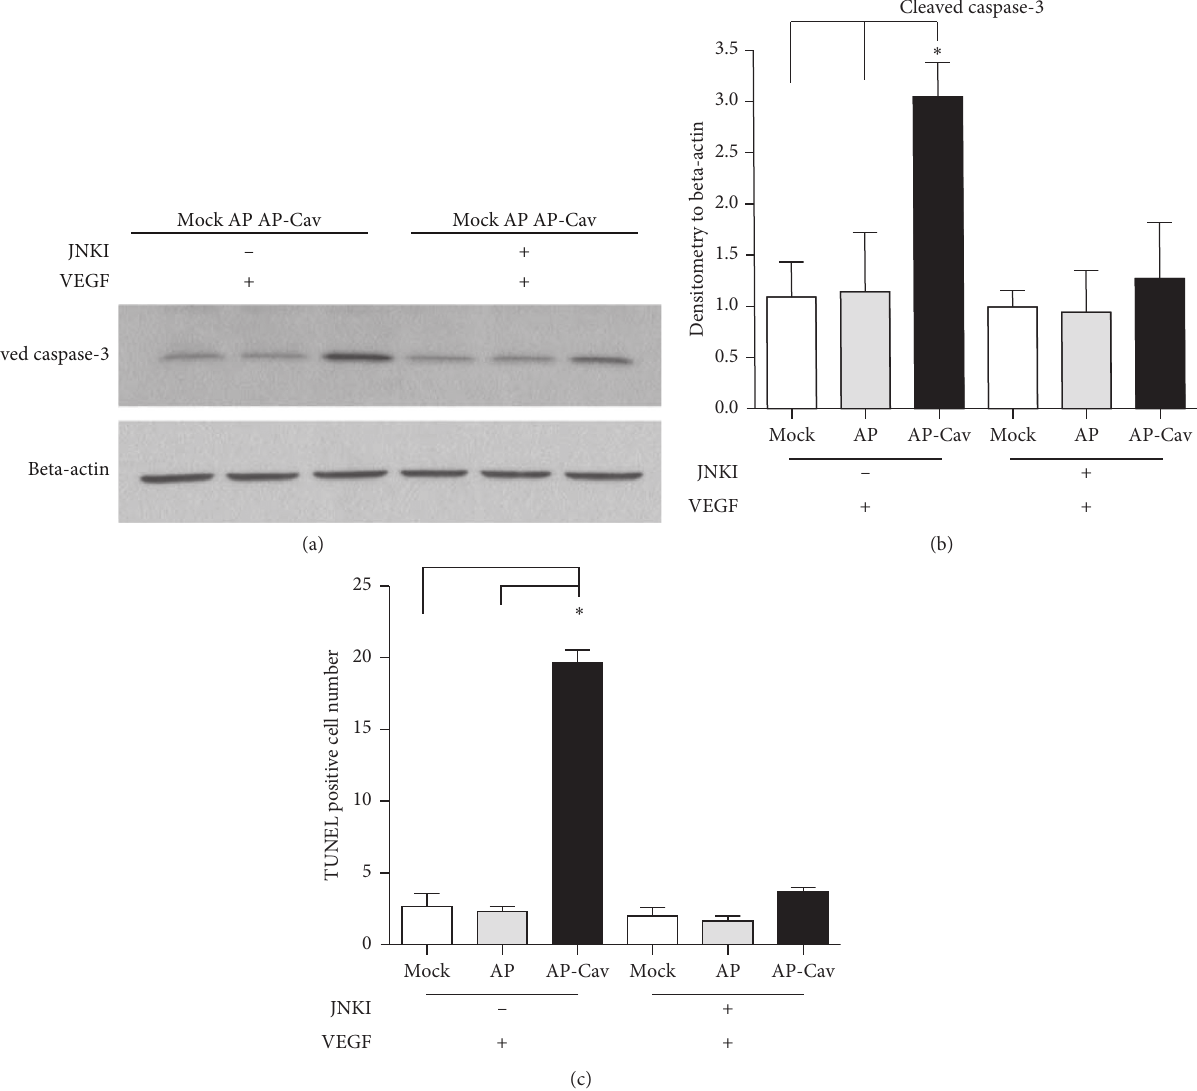
Figure 5: JNK inhibition reverses the effect of AP-Cav on mouse colon endothelial cell apoptosis. Mouse colon endothelial cells were starved in media containing 1% FBS overnight, treated with JNK inhibitor for 1 hour, incubated for 30 minutes with AP or AP-Cav peptide, and stimulated with 50ng/ml of VEGF for 4 hours. (a) At the end of the treatment, the cells were lysed in boiling SDS-sample buffer followed by western blot analysis with antibody for activated form of caspase-3. (b) Bar graph represents relative cleaved form of caspase-3 level normalized to beta-actin level. (c) At the end of the treatment, the cells were fixed and analyzed using fluorescein FragEL DNA frag- mentation detection kit and then evaluated for apoptotic cells under a fluorescence microscope. The TUNEL positive cell number per field under 10x objective was counted. Data are mean ± s.e.m. from three independent experiments, ∗ p < 0 .